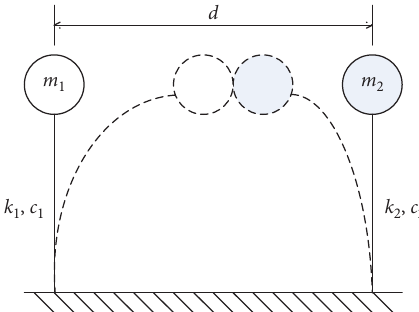
Figure 2: Pounding model of two inelastic SDOF